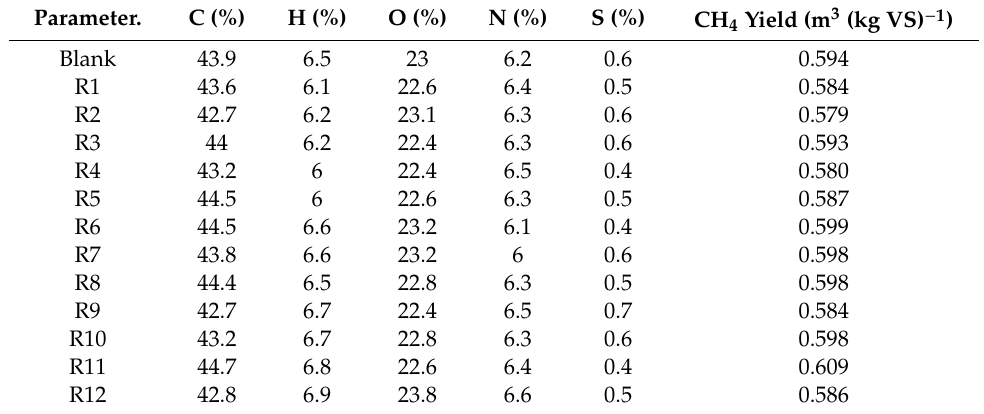
Table 8. Elemental composition of waste hydrated sludge according to di ff erent operating conditions. Parameter.